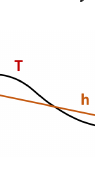
Figure 11. Concave ST-interval